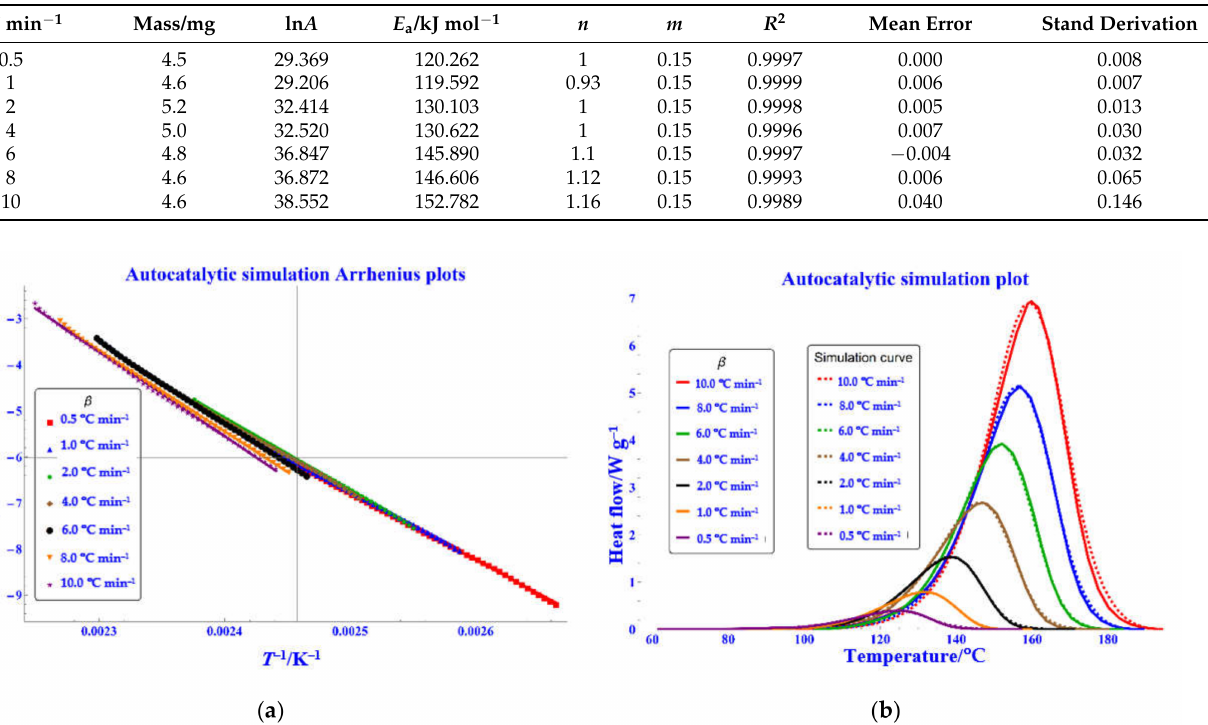
Table 7. Kinetic parameters of B/D method simulation result of BTBPC.